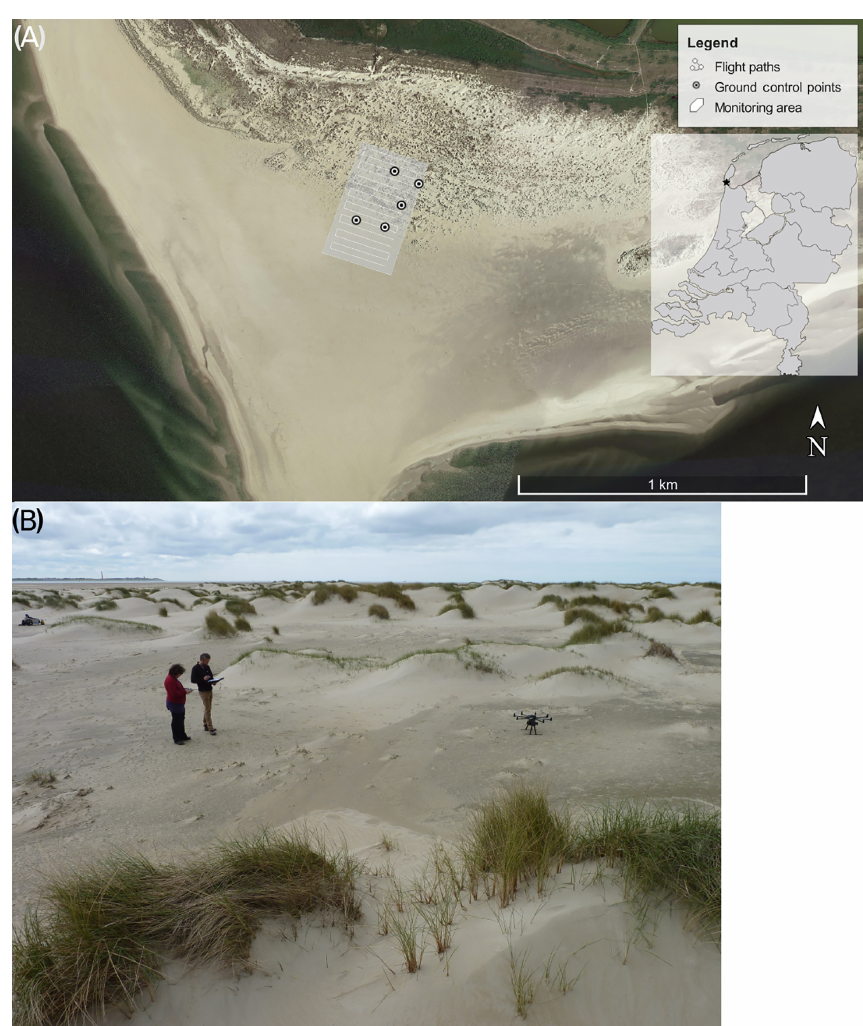
Figure 1. (a) Overview of the Hors on Texel, the Netherlands. The white lines show the flight path for the four different flights. The points show the position of the ground control markers. The white polygon is the monitoring area, which is 200m × 400m. (b) Photograph of the study site with the UAV used to monitor the nebkha